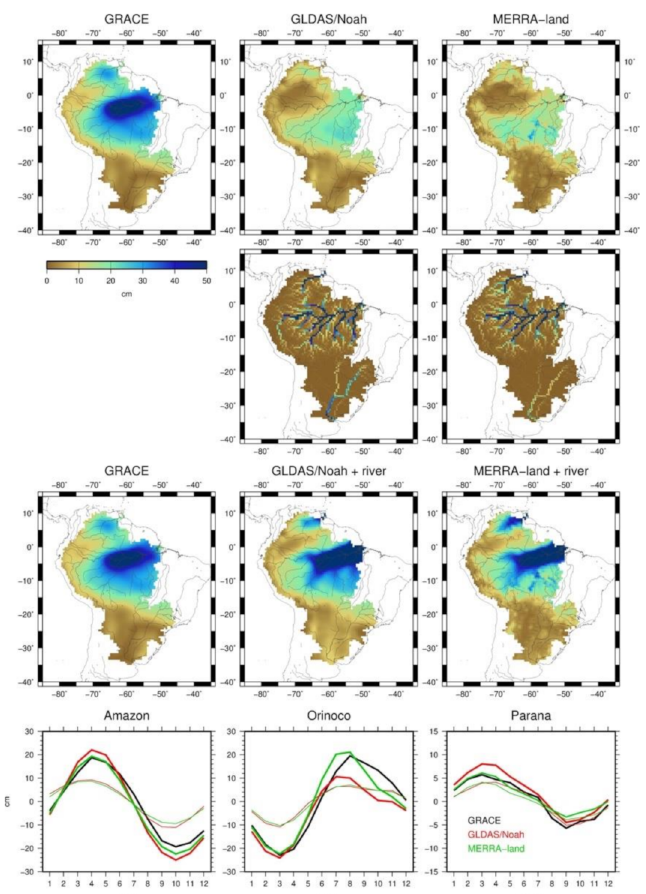
Figure 3. From top to bottom, annual amplitude (in cm) of GRACE, GLDAS/Noah and MERRA-land hydrology for the Amazon, Orinoco and Parana river basin ( top ), and surface water changes modeled with GLDAS/Noah and MERRA-land runoffs. Annual amplitude (in cm) of GRACE, GLDAS/Noah and MERRA-land after adding the river storage filtered at GRACE resolution and finally, mean seasonal mass variability per basin for GRACE (black), GLDAS/Noah (in red, thin line: mass changes from the hydrology model, thick line: total mass changes i.e., hydrology + river) and MERRA-land (in green) ( bottom